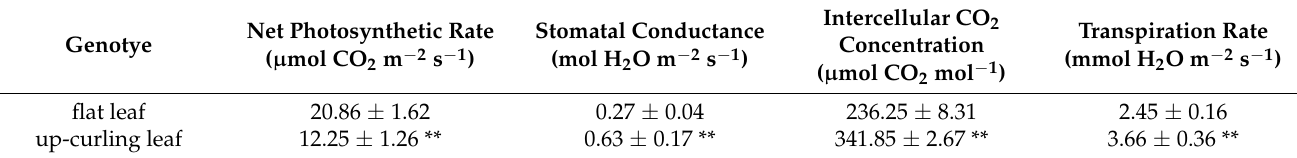
Table 2. Leaf photosynthetic indicators of homozygous up-curling leaf and flat leaf in the F 2 population (mean ± SD, n = 4 for each sample).